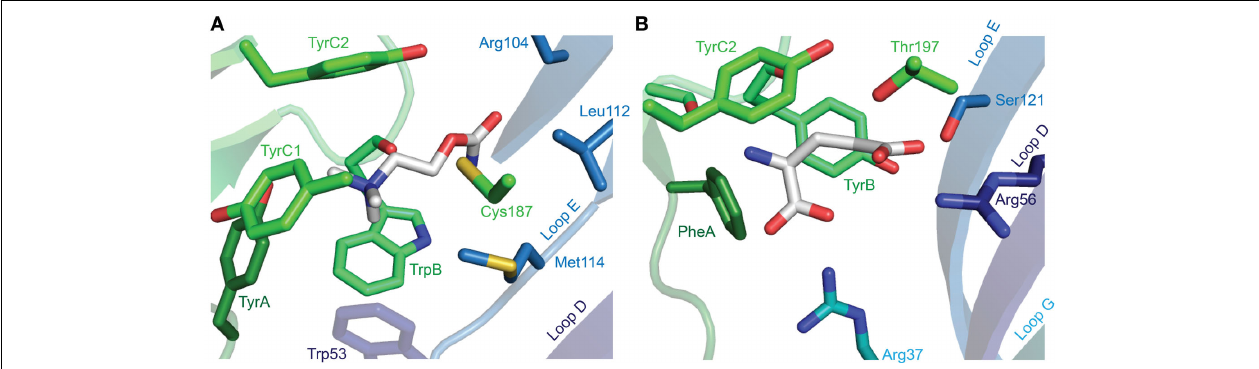
FIGURE 5 | X-ray crystallographic structures of agonist-bound receptors. (A) L. stagnalis AChBP in complex with carbamylcholine (PDB entry 1UV6). (B) C. elegans α GluCl (GLC-1) in complex with glutamate (and ivermectin in